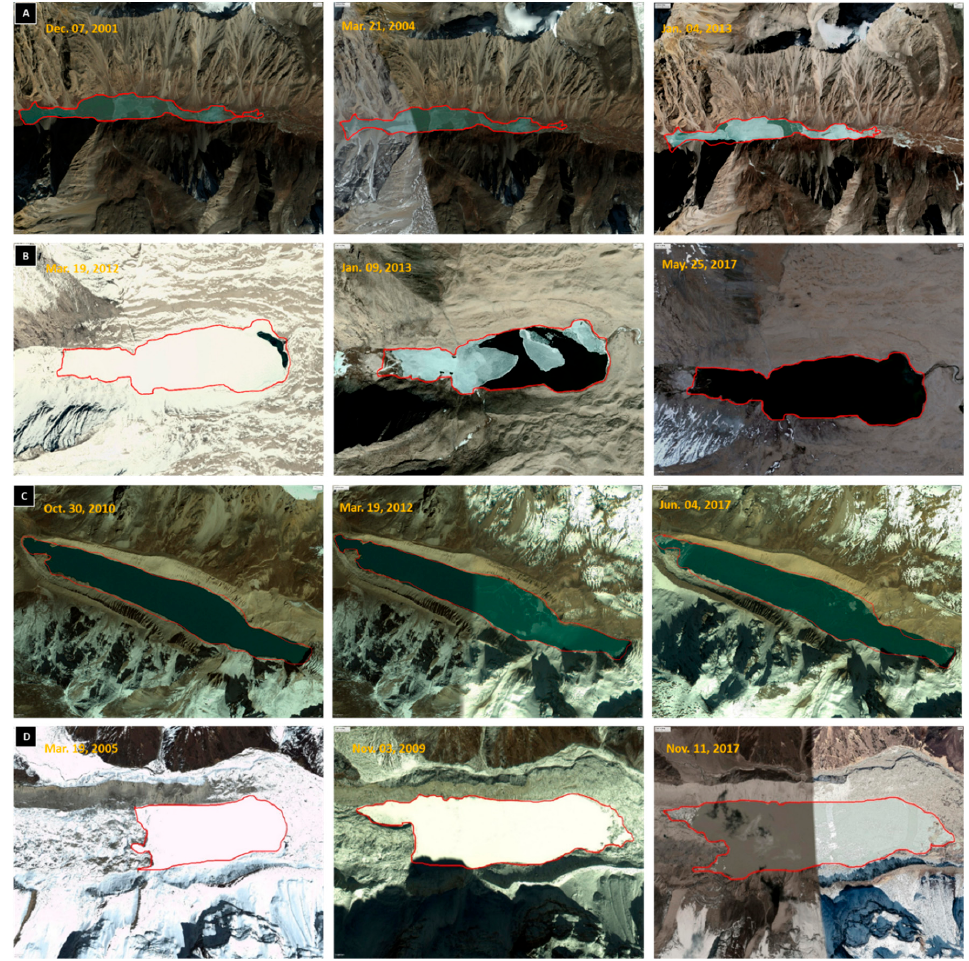
Figure A3. Glacial lake change in area profile during the period 2005–2017, where ( a ), ( b ), ( c ), and ( d ) represent lake nos. 20, 35, 36, and 49, respectively (Source: Google Earth).